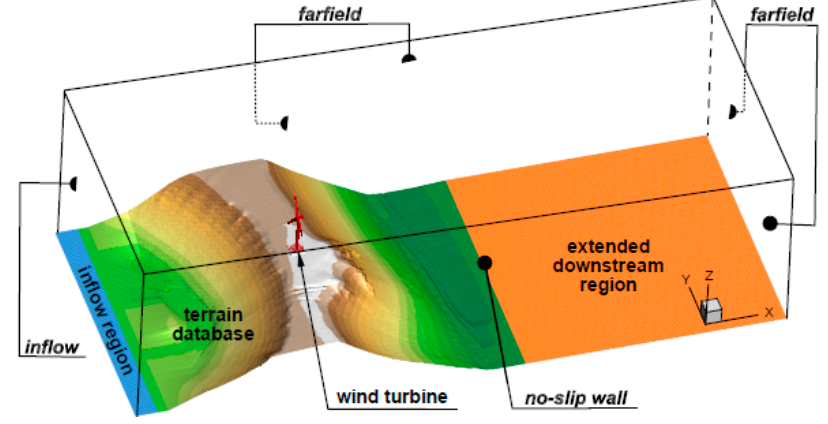
Figure 20. Computational domain of a wind turbine in a complex terrain [100].